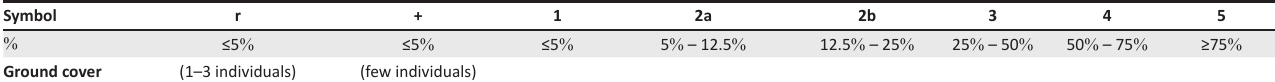
TABLE 1: Braun–Blanquet cover abundance scale used – Symbols and associated percentage. Symbol r + 1 2a Ground